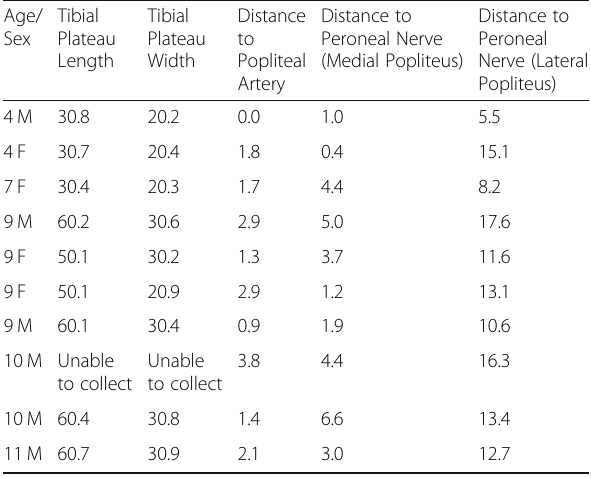
Table 1 Age of specimens, Tibial plateau dimensions, and distance from meniscal repair device to neurovascular structures. (All measurements presented in mm)